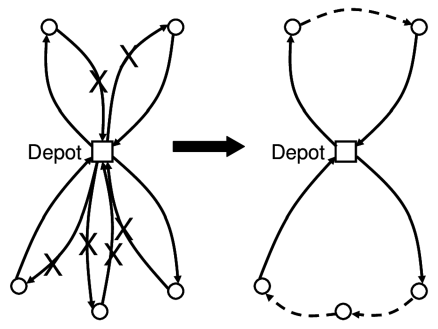
Figure 2. Concept of the Savings Algorithm. Reprinted/adapted with permission from Ref. [82]. 2015, ProQuest Information and Learning